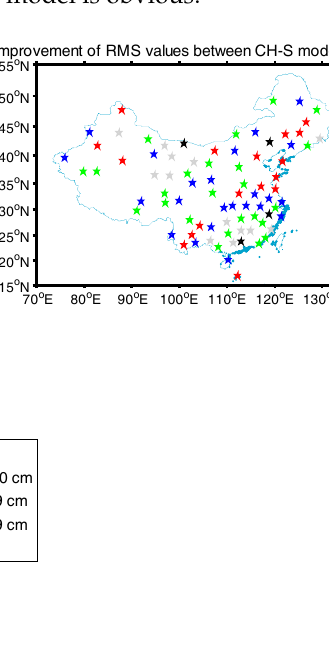
Figure 4. The improvement in the RMS values for the three pairs of tropospheric